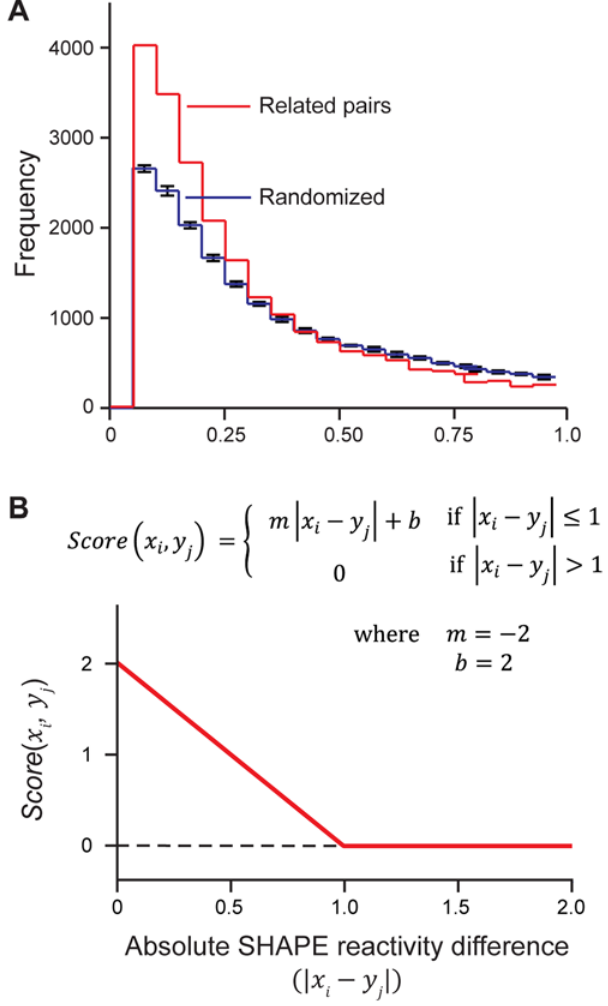
Fig 1. SHAPE-based scoring function for structurally-informed RNA sequence alignment. ( A ) Histogram of the absolute differences in SHAPE reactivities for paired nucleotides in accepted alignments. Differences between related pairs are shown in red, and differences between randomized pairs are blue. Pairs were randomized in eight individual trials; average values are shown with standard deviations given as error bars. ( B ) Scoring function used to compare SHAPE values at positions i and j in sequences x and y ,